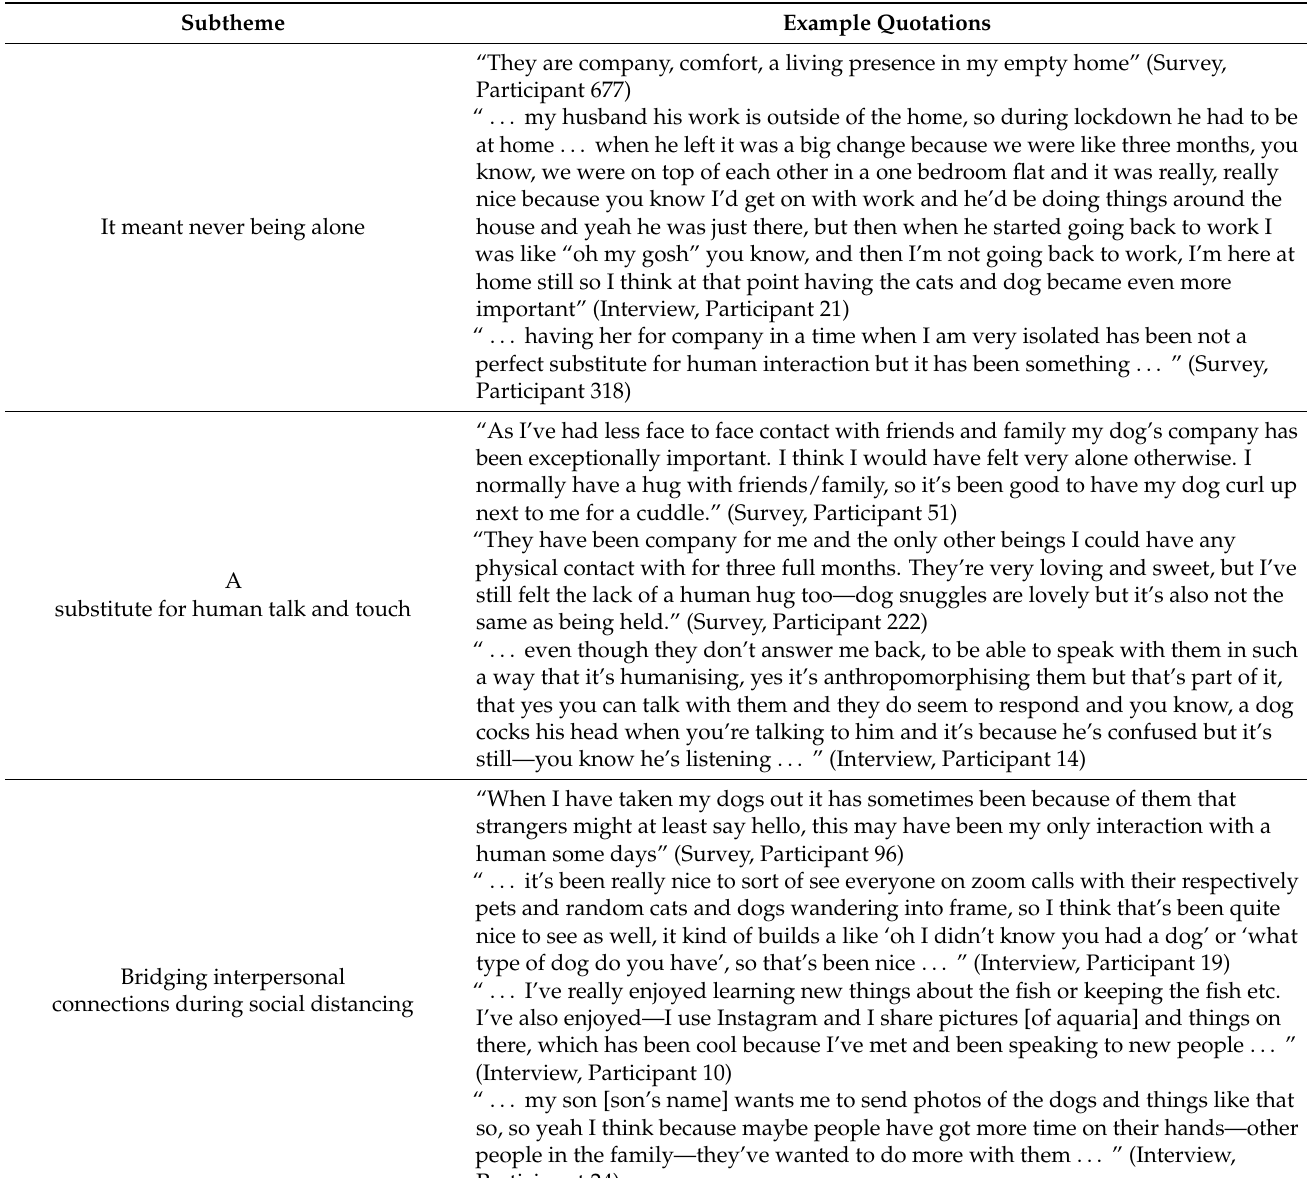
Table 3. Example quotations for “Companion animals as providers of social